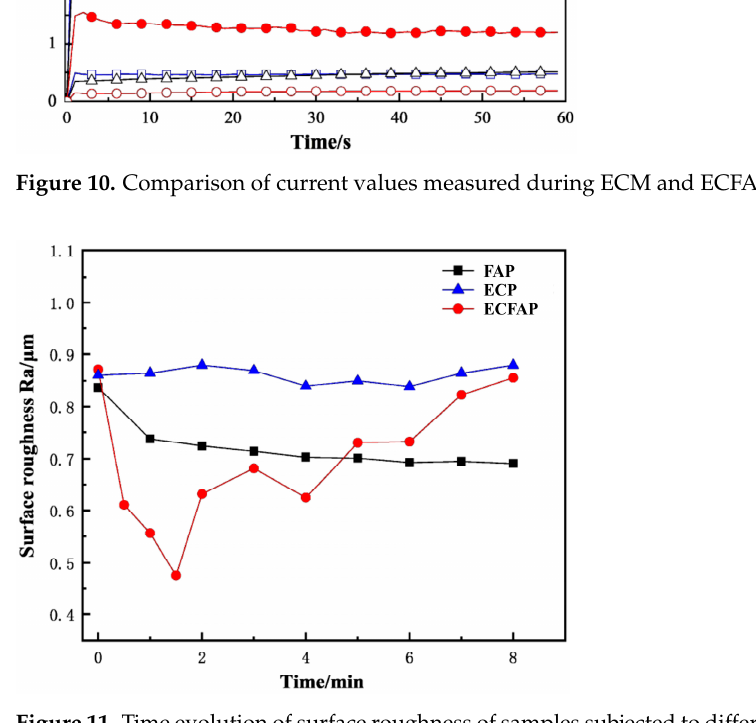
Figure 10. Comparison of current values measured during ECM and ECFAP treatments.